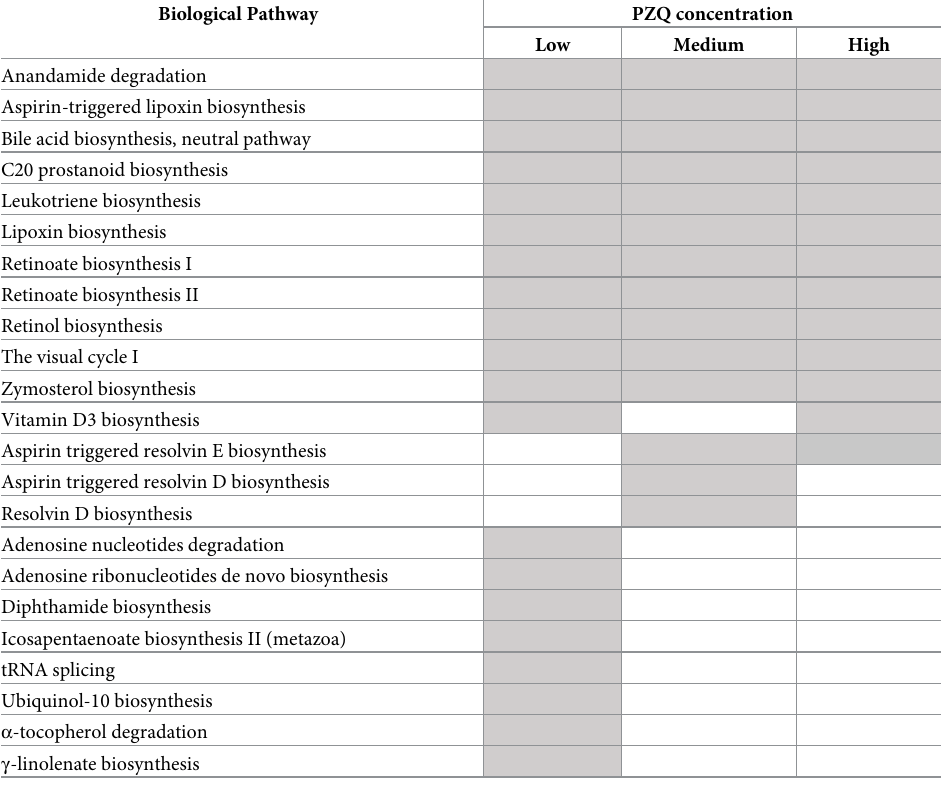
Table 3. Biological pathways altered by different concentrations of PZQ. Gray color represents alterations in bio- logical pathways with p < 0.05.